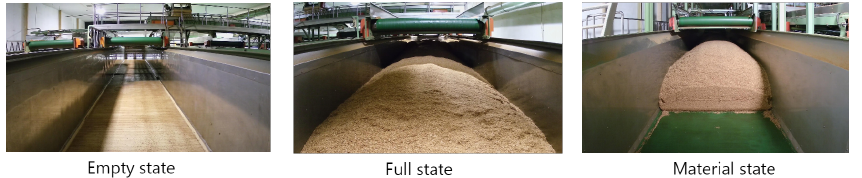
Figure 3. Tobacco cabinet data. The left is the empty state, the middle is the full state, and the right is the material state.